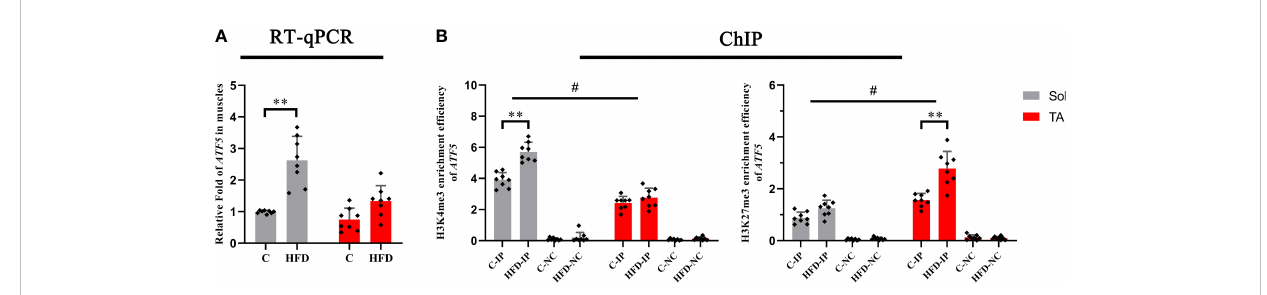
FIGURE 6 The transcription level and histone methylation at the promoter region of ATF5. (A) The transcription level of ATF5 in Sol and TA muscles among the groups; (B) The H3K4me3 and H3K27me3 enrichment rate of the ATF5 promoter in Sol and TA muscles among the groups. **p<0.01; and #p<0.05 when comparison was conducted between muscles; n=8 for each group; IP, immunoprecipitation; NC, negative control).